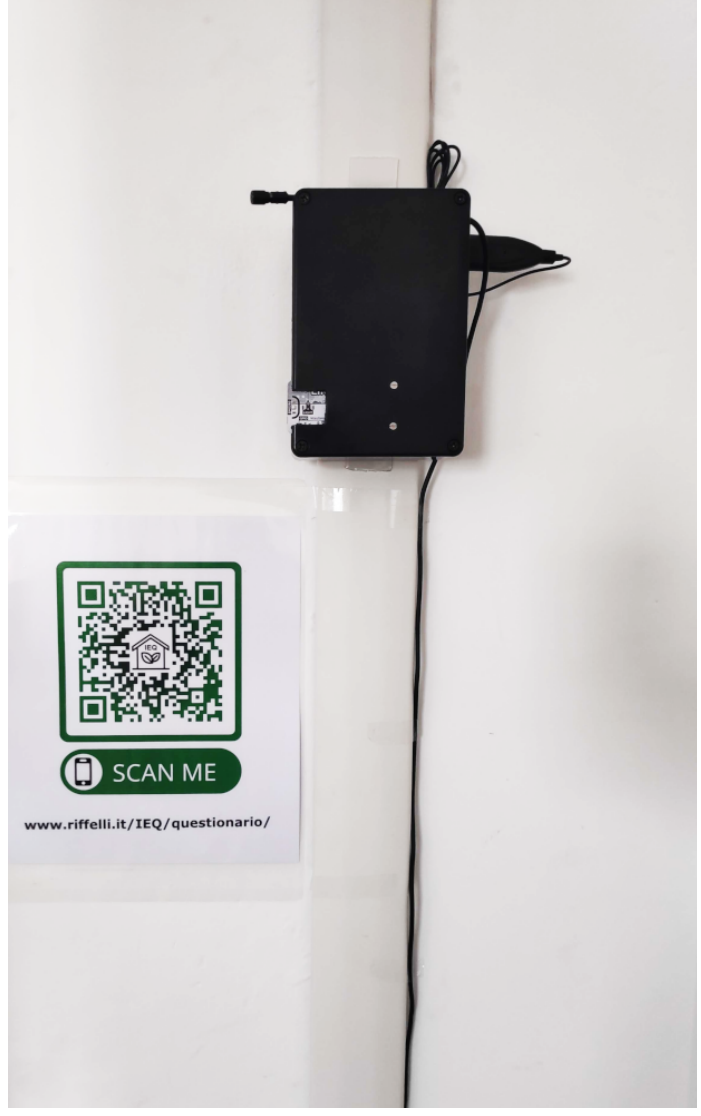
Figure 9. Wireless IEQ logger: system installation in the